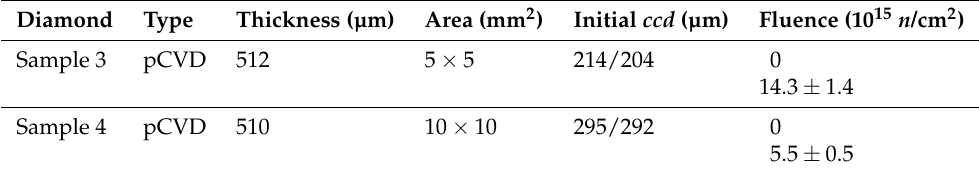
Table 2. Properties of diamonds irradiated with neutrons and the fluence they received. The initial unirradiated Charge Collection Distance ( ccd ) values are given separately for positive and negative bias polarity ( E = 2V/µm). ±